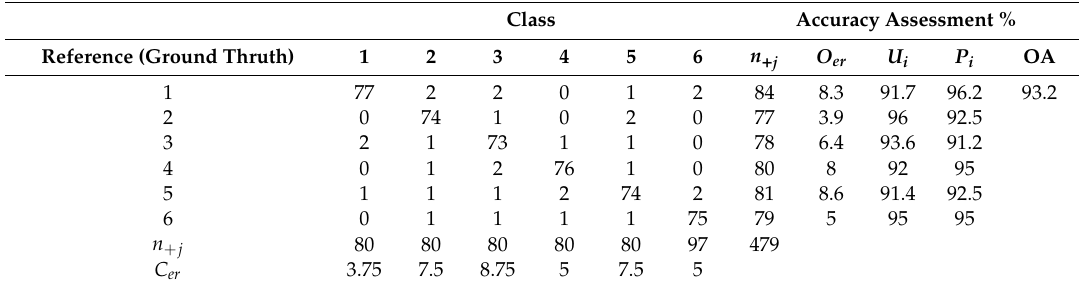
Table 4. Pixel counts of the error matrix with overall accuracy